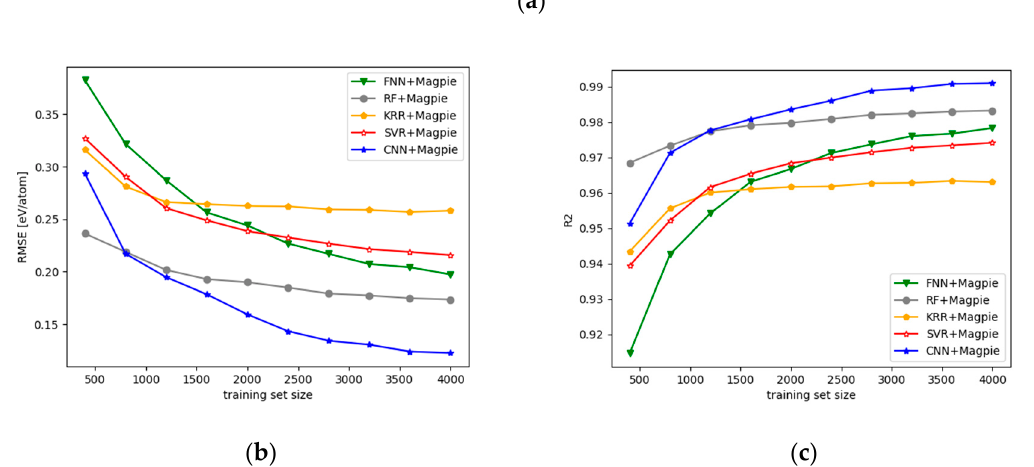
Figure 4. Prediction performance of different models using Magpie descriptors. ( a ) MAE of different training set size. ( b ) RMSE of different training set size. ( c ) R 2 of different training set size. Table 2. RMSE (eV/atom), MAE (eV/atom) and R 2 values of cross-validation results for each prediction model using Magpie descriptors.